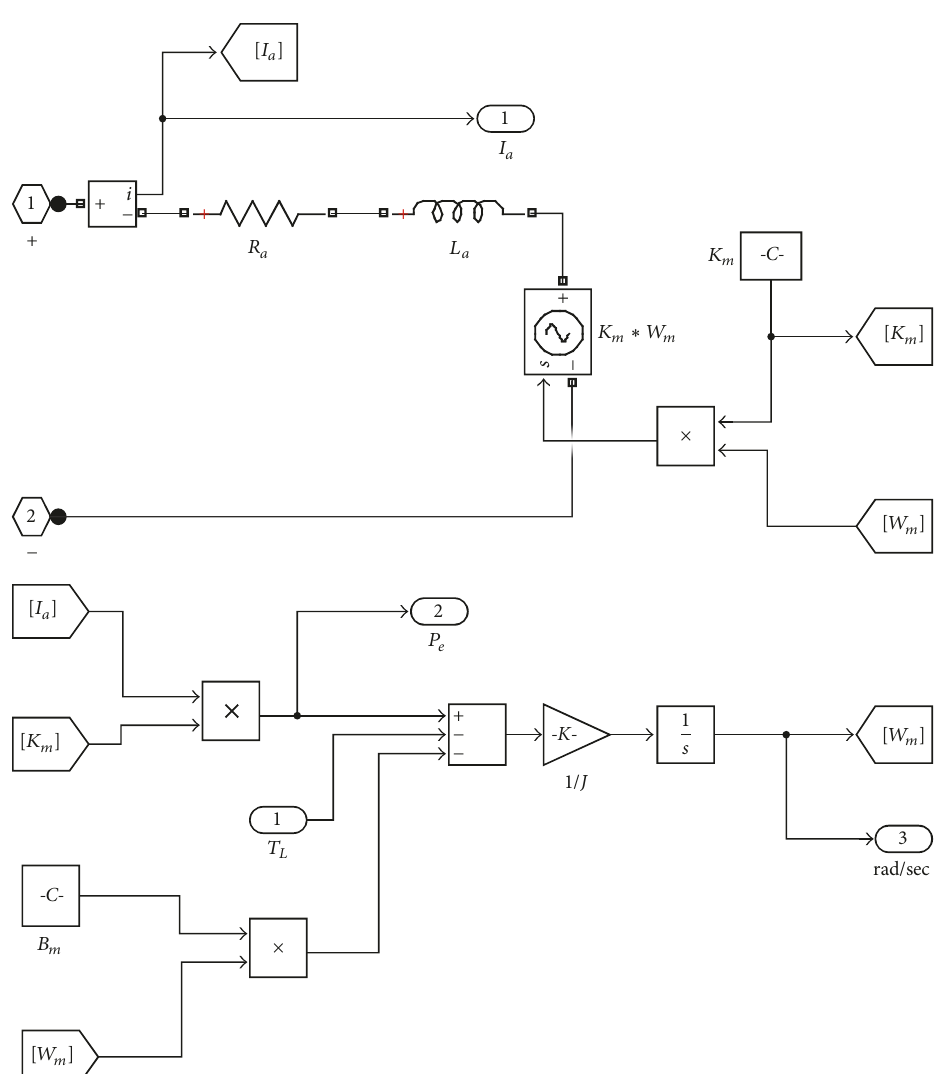
Figure 13: Detailed model of a permanent magnetic DC